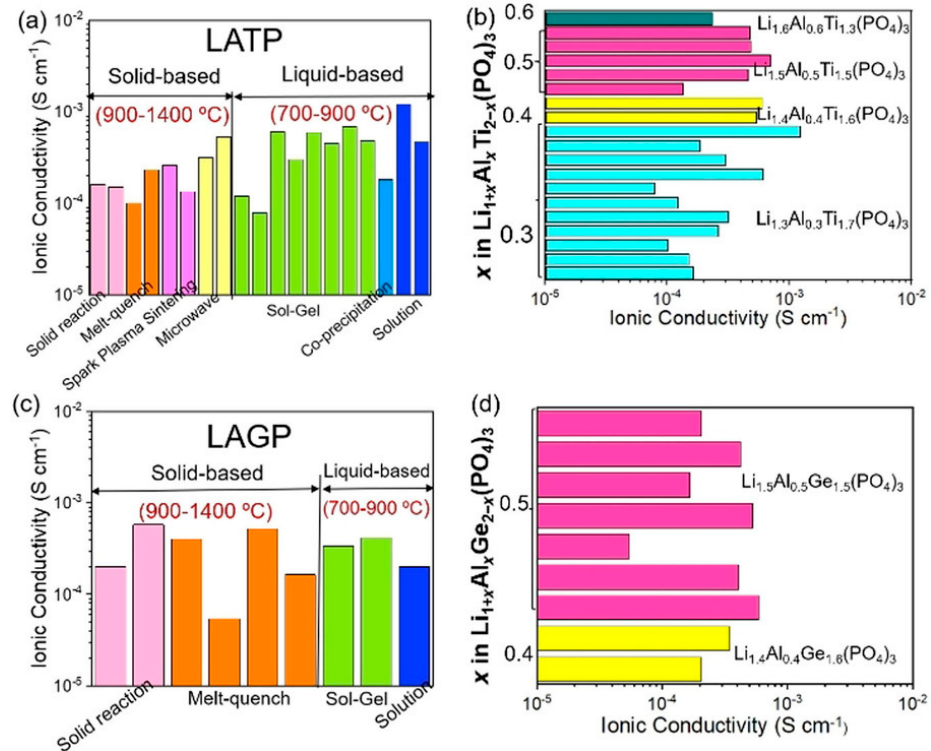
Figure 30. Dependence of ionic conductivities of ( a ) and ( b ) Li 1.5 Al 0.5 Ti 1.5 P 3 O 12 (LATP) and ( c ) and ( d ) Li 1.5 Al 0.5 Ge 1.5 P 3 O 12 (LAGP) solid electrolytes that were obtained using different synthesis methods and presented different Al contents. Reproduced with permission from [49]. Copyright 2019 Wiley.